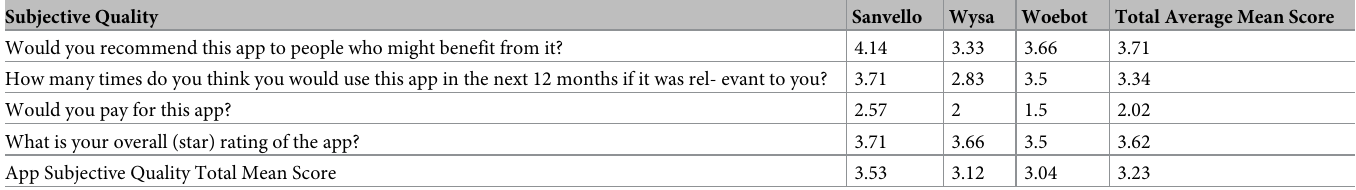
Table 5. Subjective quality scorers of the uMARS questionnaire. Subjective